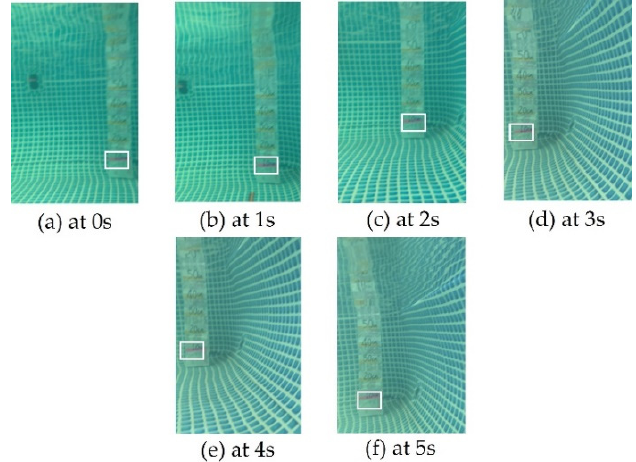
Figure 24. Experimental results for the son underwater robot target object acquisition and identifi- cation. (The white box is the target object.)